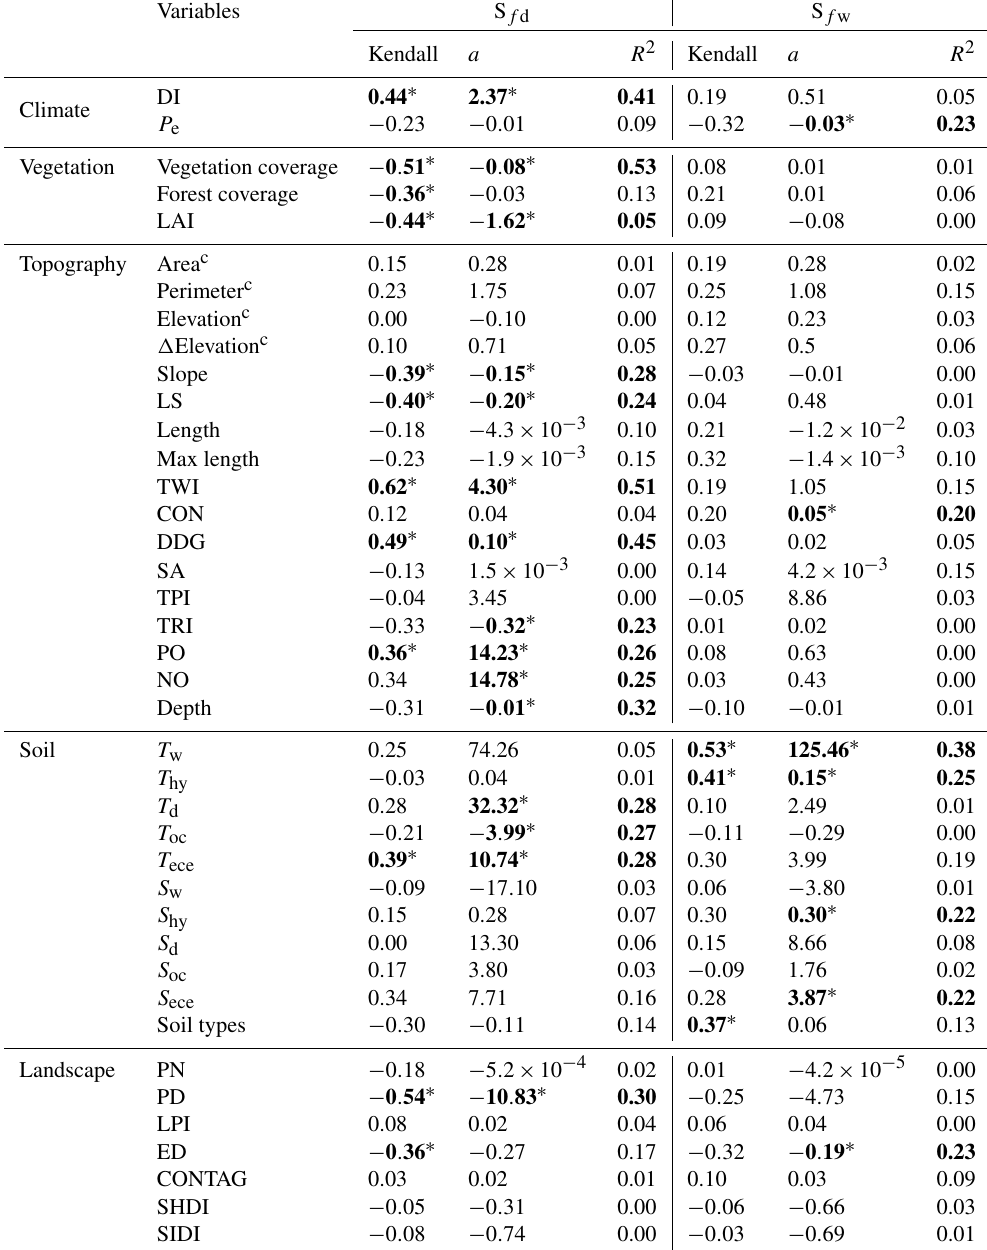
Table 6. Correlation analysis between seasonal ecohydrological sensitivities and contributing